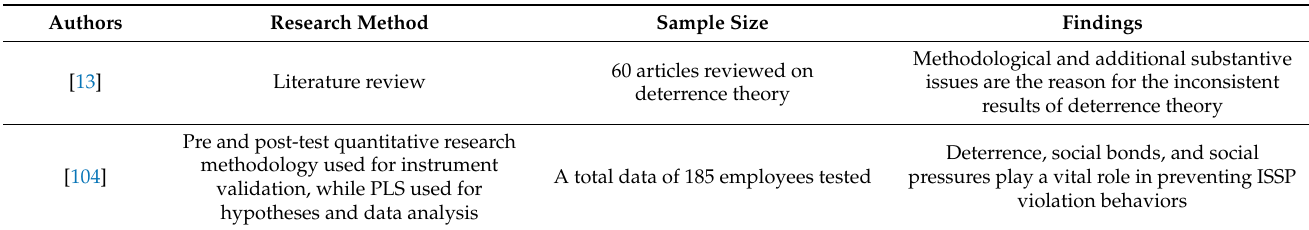
Table 13. Studies on deterrence and